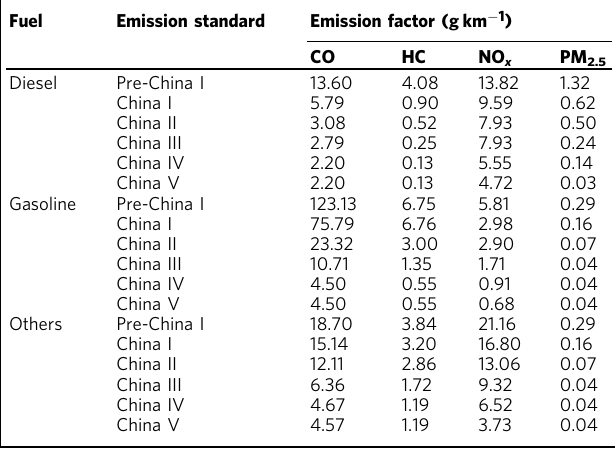
Table 1 Emission factors of all HDT